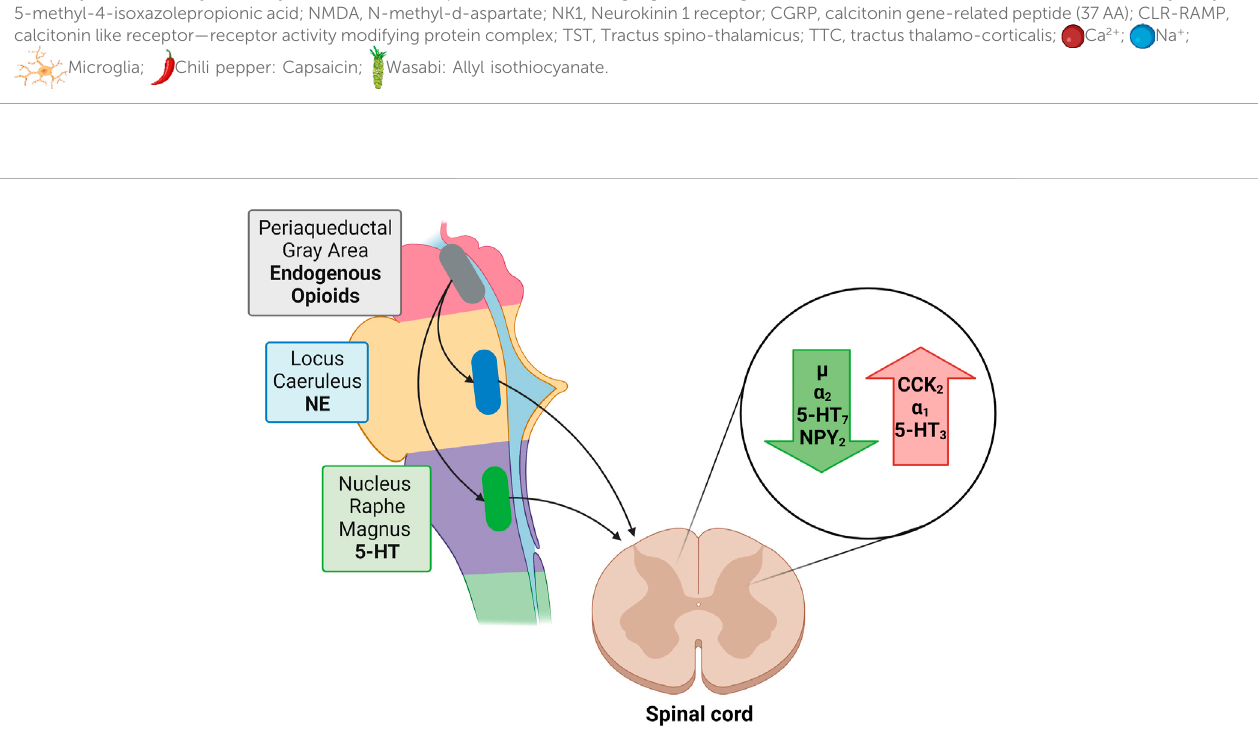
FIGURE 3 Green arrow: Receptors reducing nociception: µ opioid receptor; α 2 , adrenergic receptor; 5-HT 7 , serotonin receptor; NPY 2 , neuropeptide Y receptor type 2. Red arrow: Receptors enhancing nociception: CCK 2 , cholecystokinin 2(B) receptor; α 1 , adrenergic receptor; 5-HT 3 , ionotropic serotonin receptor; Periaqueductal Gray: Endogenous Opioids; Locus Caeruleus: NE; Nucleus Raphe Magnus: